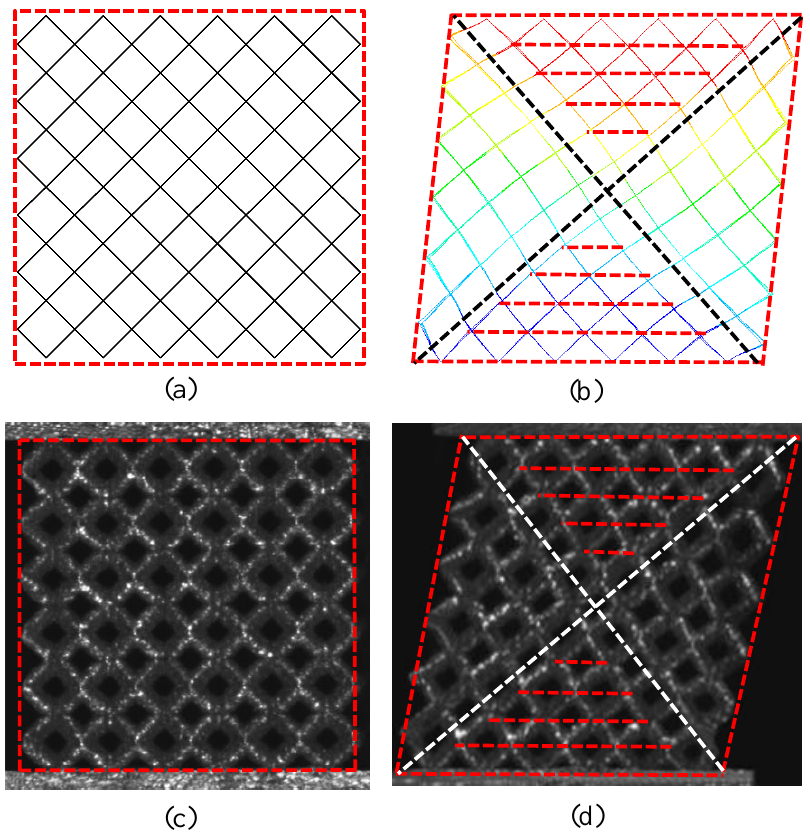
Figure 14. Deformation patterns of the sandwich BCC lattice: ( a ) initial FE model; ( b ) deformation of FE model; ( c ) initial state of sample; ( d ) deformed sample. Table 3. Finite Element and Theoretical Derivation Calculation.